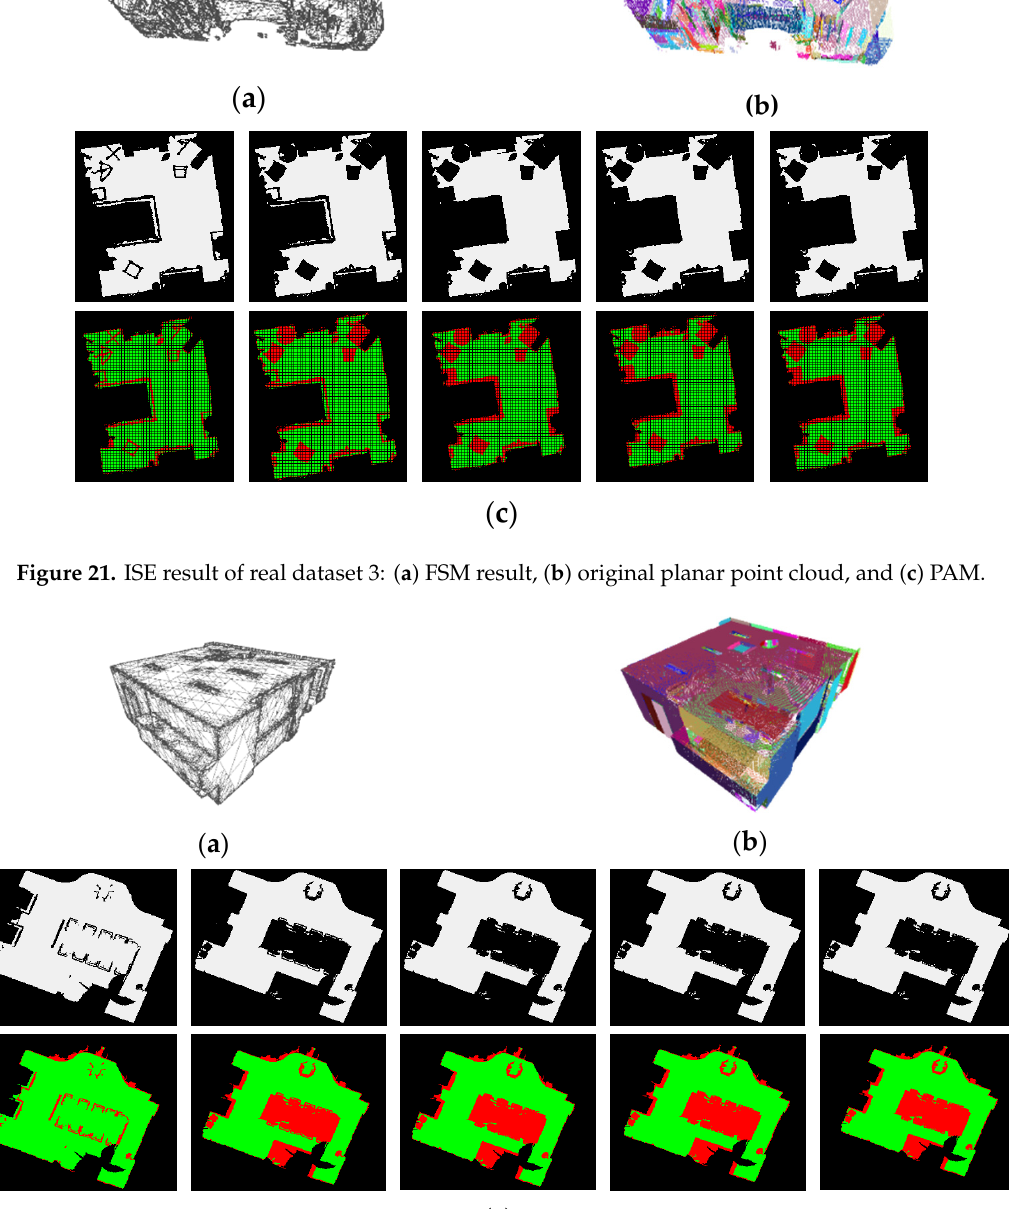
Figure 22. ISE result of real dataset 4: ( a ) FSM result, ( b ) original planar point cloud, and ( c ) PAM.